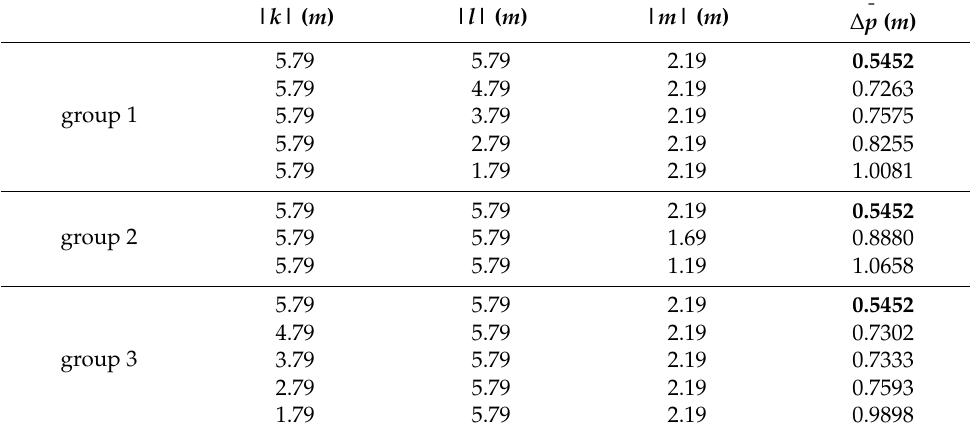
Table 12. The 3D RMSPE ∆ p with varying anchor distances | k | , | l | , and | m | for the NLOS